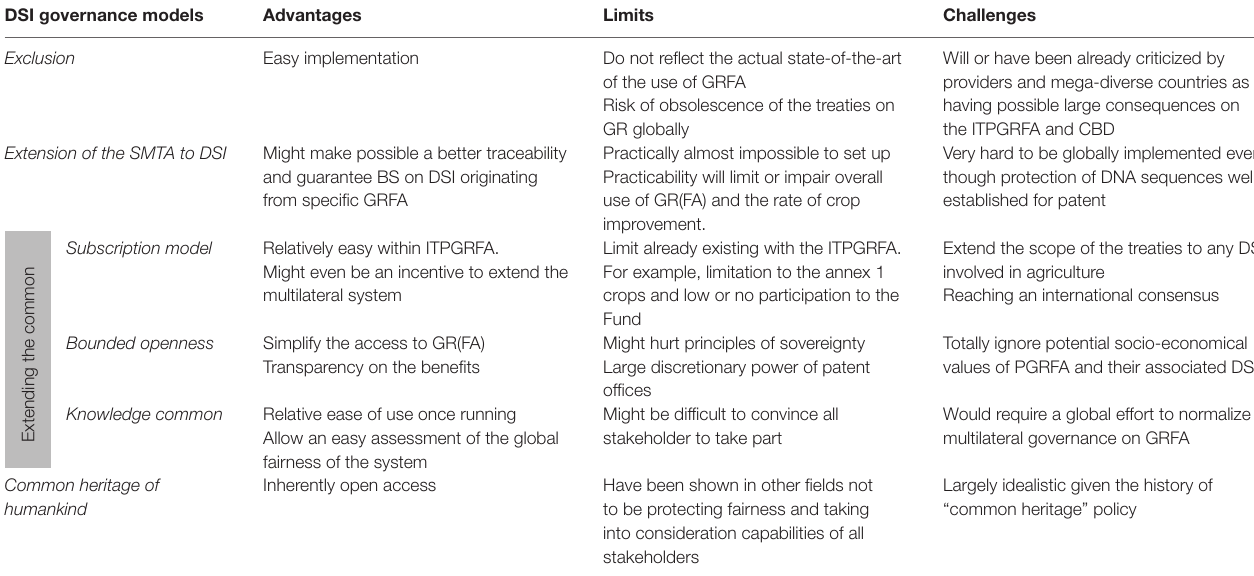
TABLE 1 | Overview of possible options to include DSI-GRFA into existing genetic resources regulatory regime and their possible advantages and